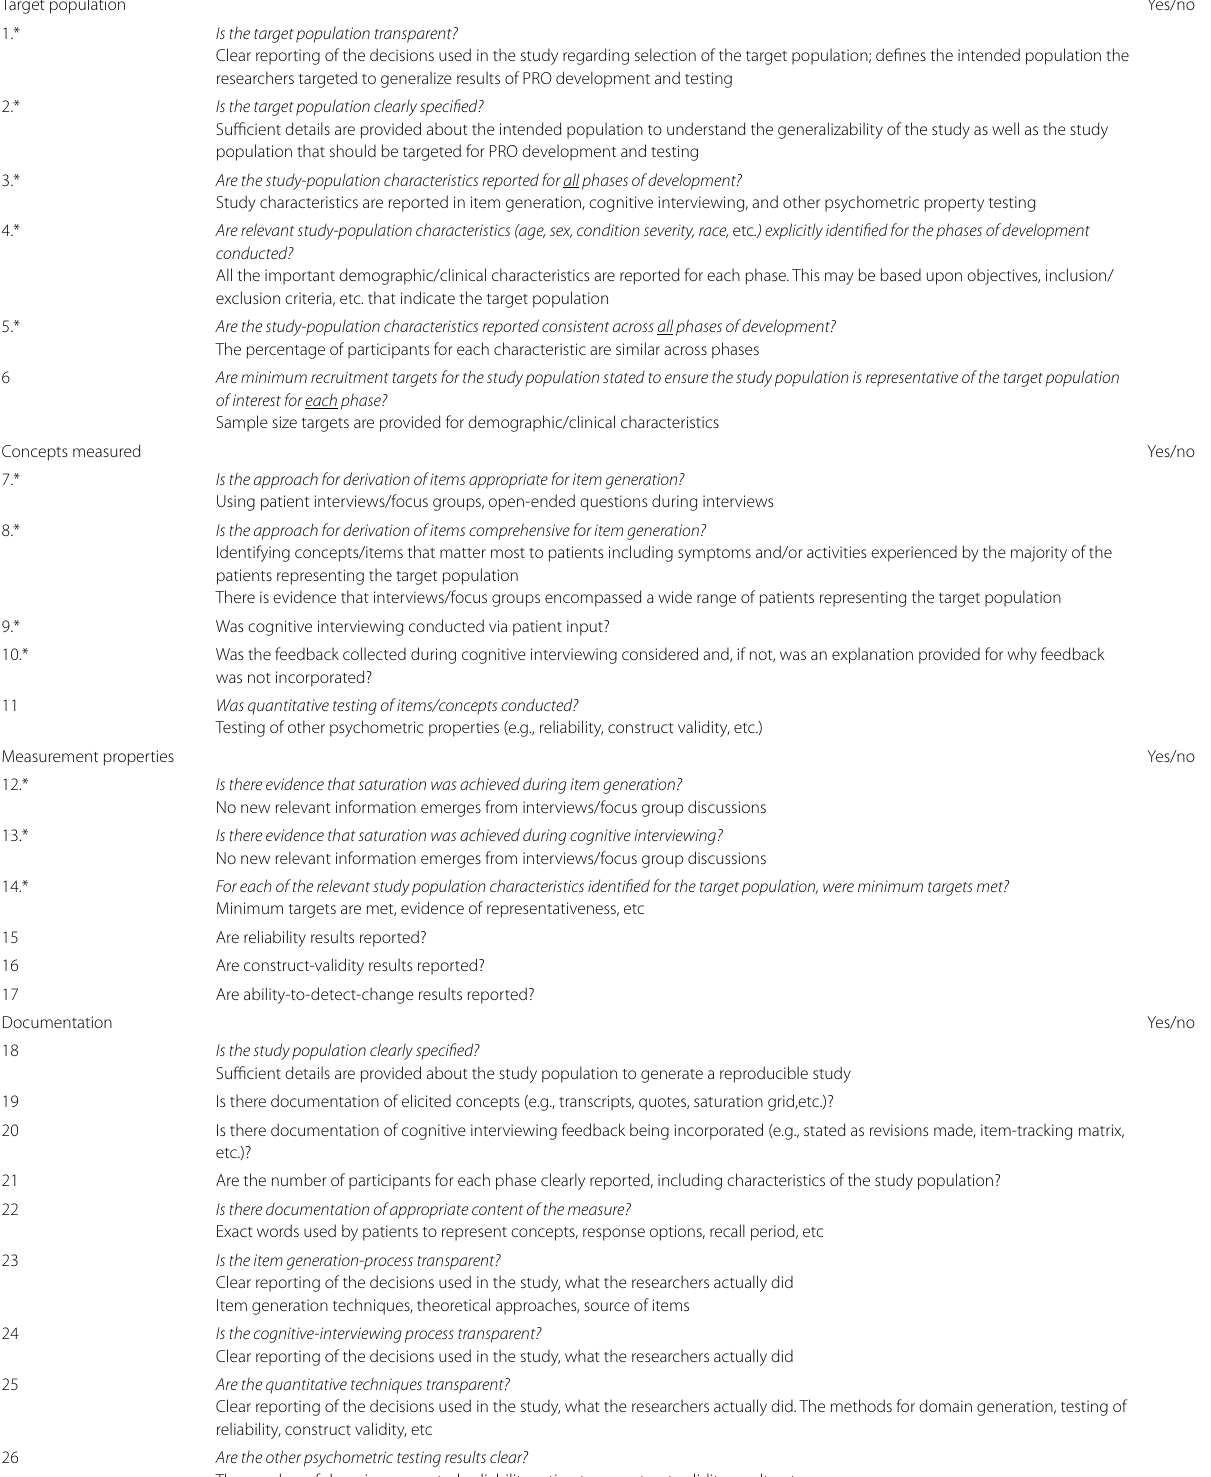
Table 1 Evaluation criteria for key components of patient‑reported outcome measure (PRO) measure development and testing Target